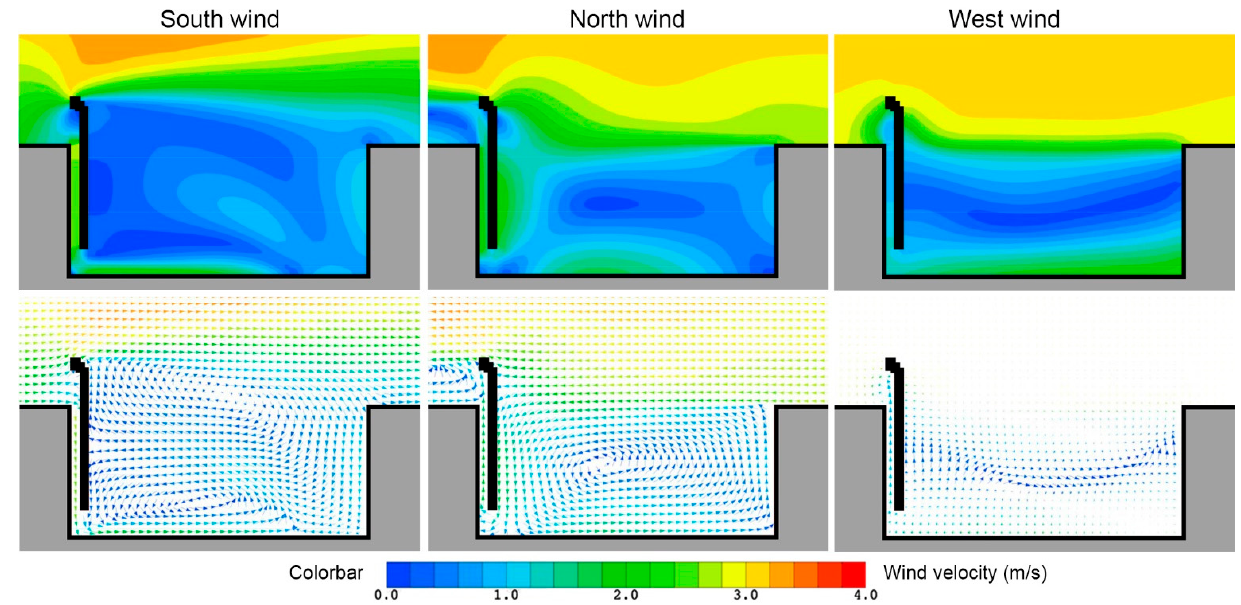
Figure 9. Ventilation performance of guiding wind wall in different wind directions.